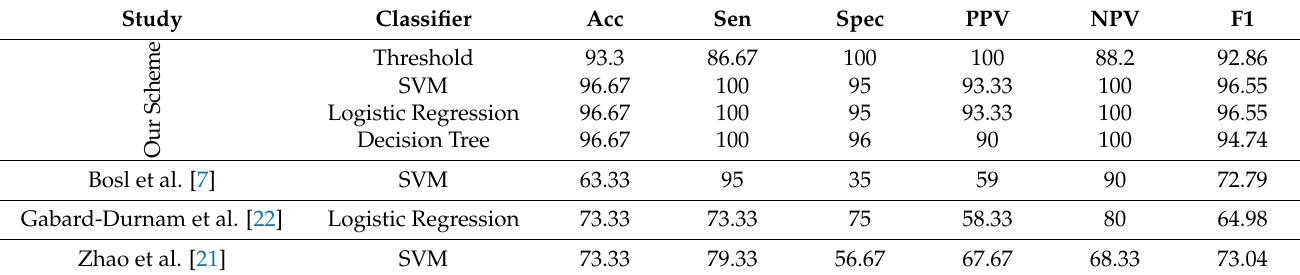
Table 6. The performance of our scheme compared with the